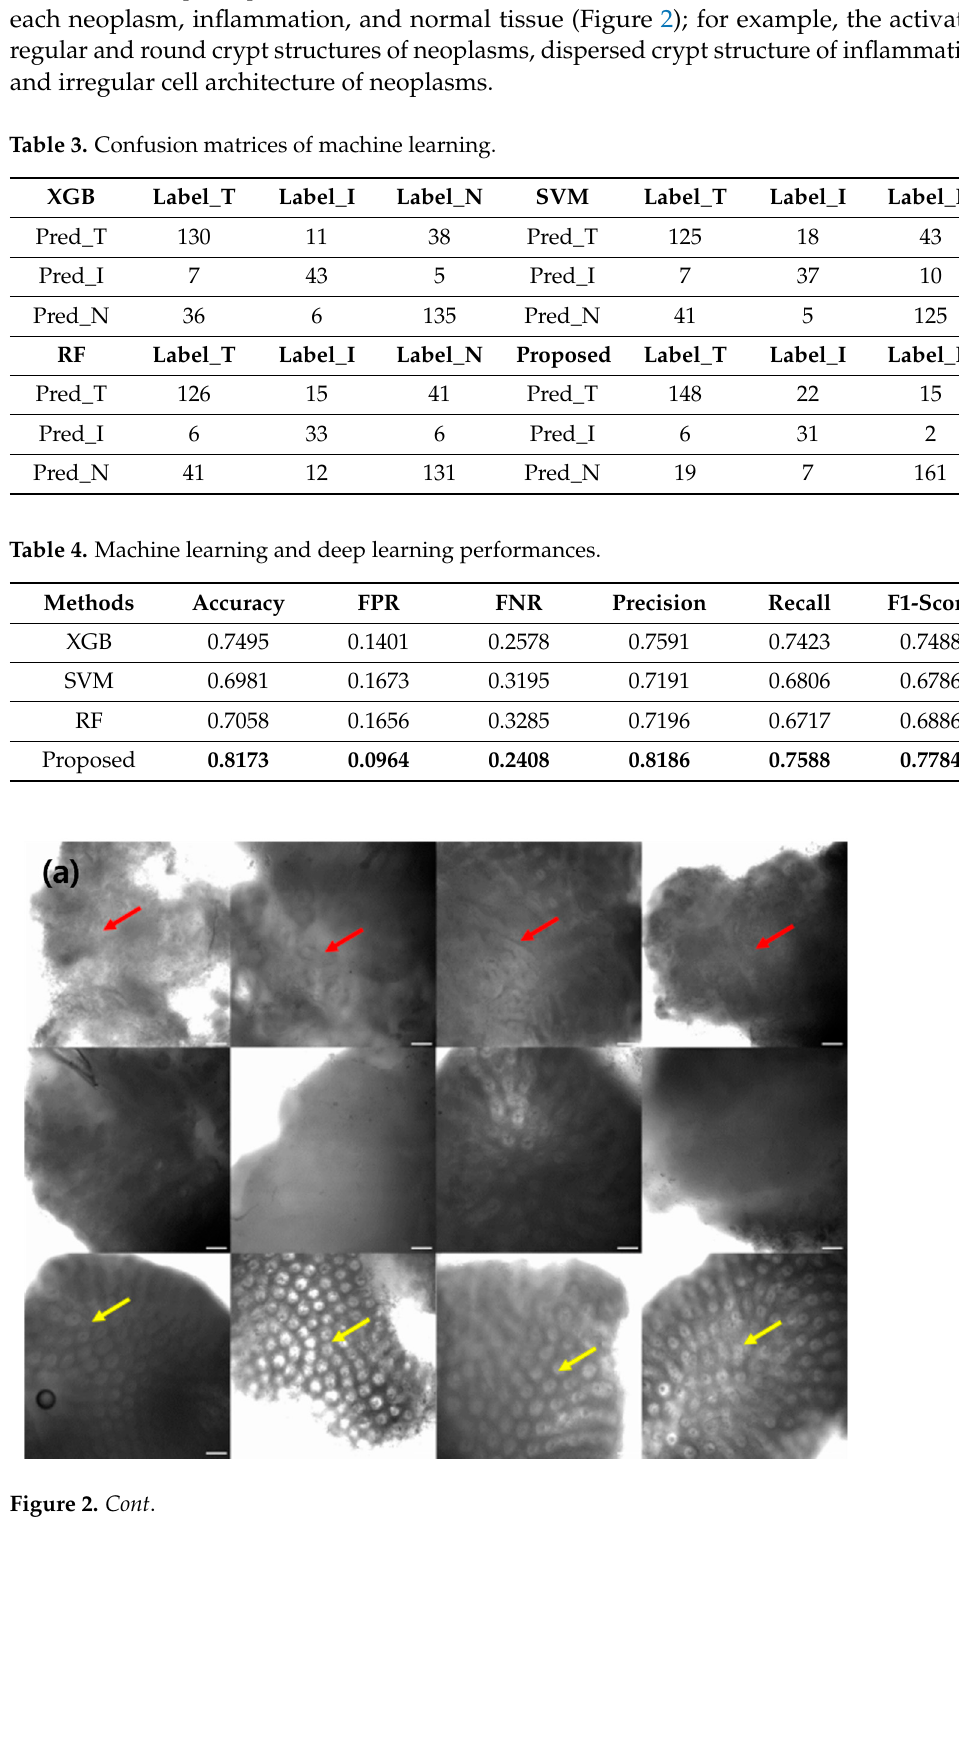
Table 4. Machine learning and deep learning performances.